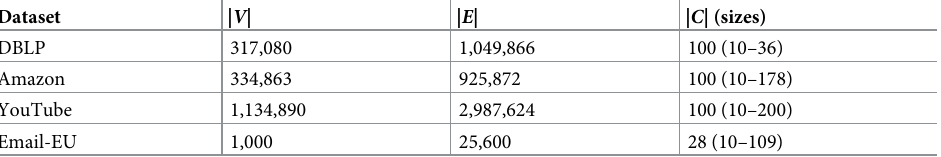
Table 2. Characteristics of datasets used in the experiments, where | V | is the number of nodes, | E | is the number of edges, | C | is the number of communities and sizes is the range of the number of nodes in each community.